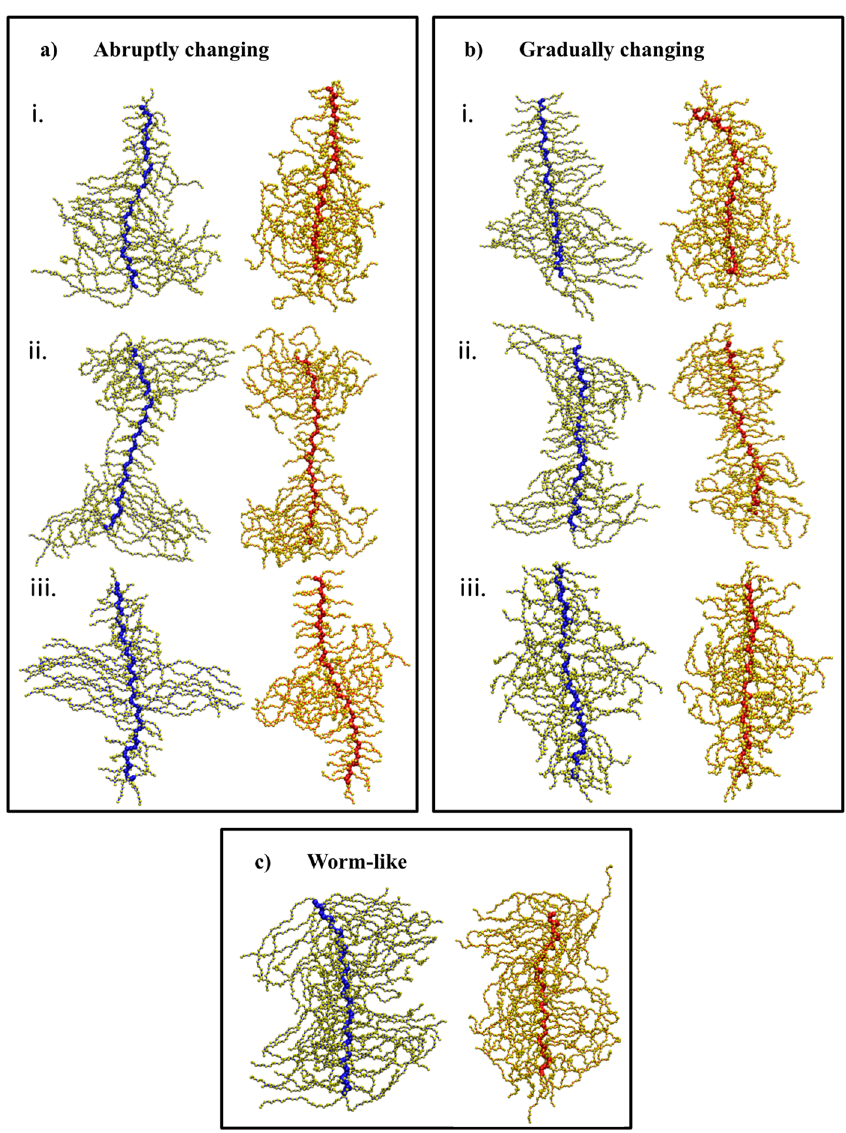
Fig. 1 Final snapshots for the BBPs after 500 ns simulation run. a Abruptly changing, b Gradually changing and c Worm-like BBPs studied after 500 ns simulation run. Abruptly changing BBPs include: a -i Cake, a -ii Dumbbell and a -iii Plus-like BBPs. Gradually changing BBPs include: b -i Cone, b -ii Hourglass and b -iii Diamond-like BBPs. Simulations at 300 K are presented with a blue BBP backbone and those at 320 K are presented with a red BBP backbone. PNIPAM side chains are represented in yellow with CG beads AMP and ISP hidden to provide a relatively simpler representation of the